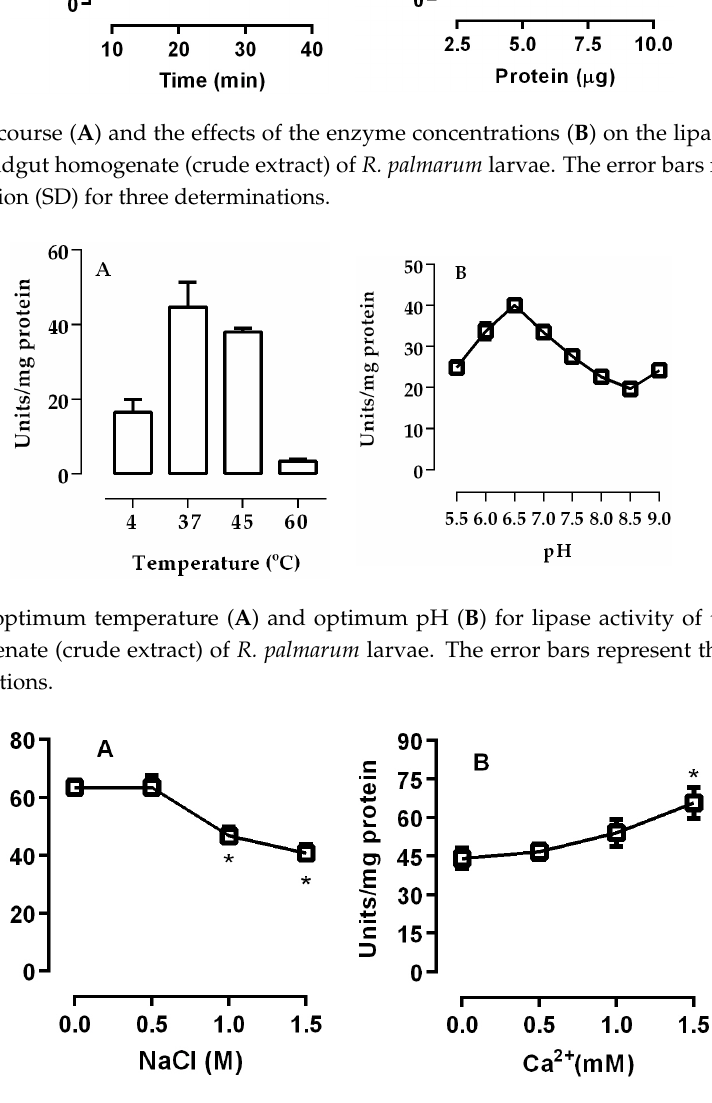
Figure 1. Time course ( A ) and the effects of the enzyme concentrations ( B ) on the lipase activity of the posterior midgut homogenate (crude extract) of R. palmarum larvae. The error bars represent the standard deviation (SD) for three determinations.